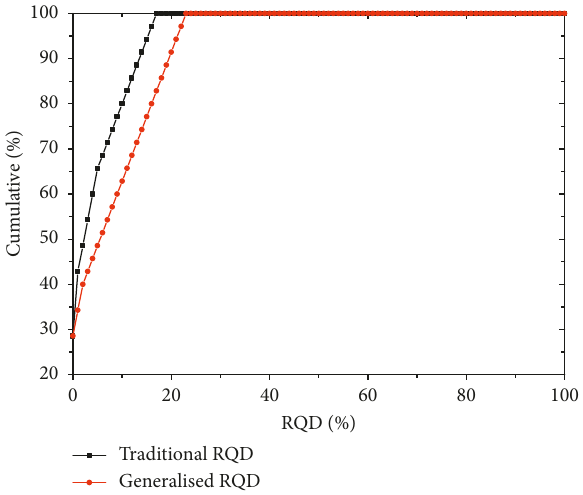
Figure 9: Comparison between the cumulative frequency curves of traditional and generalised